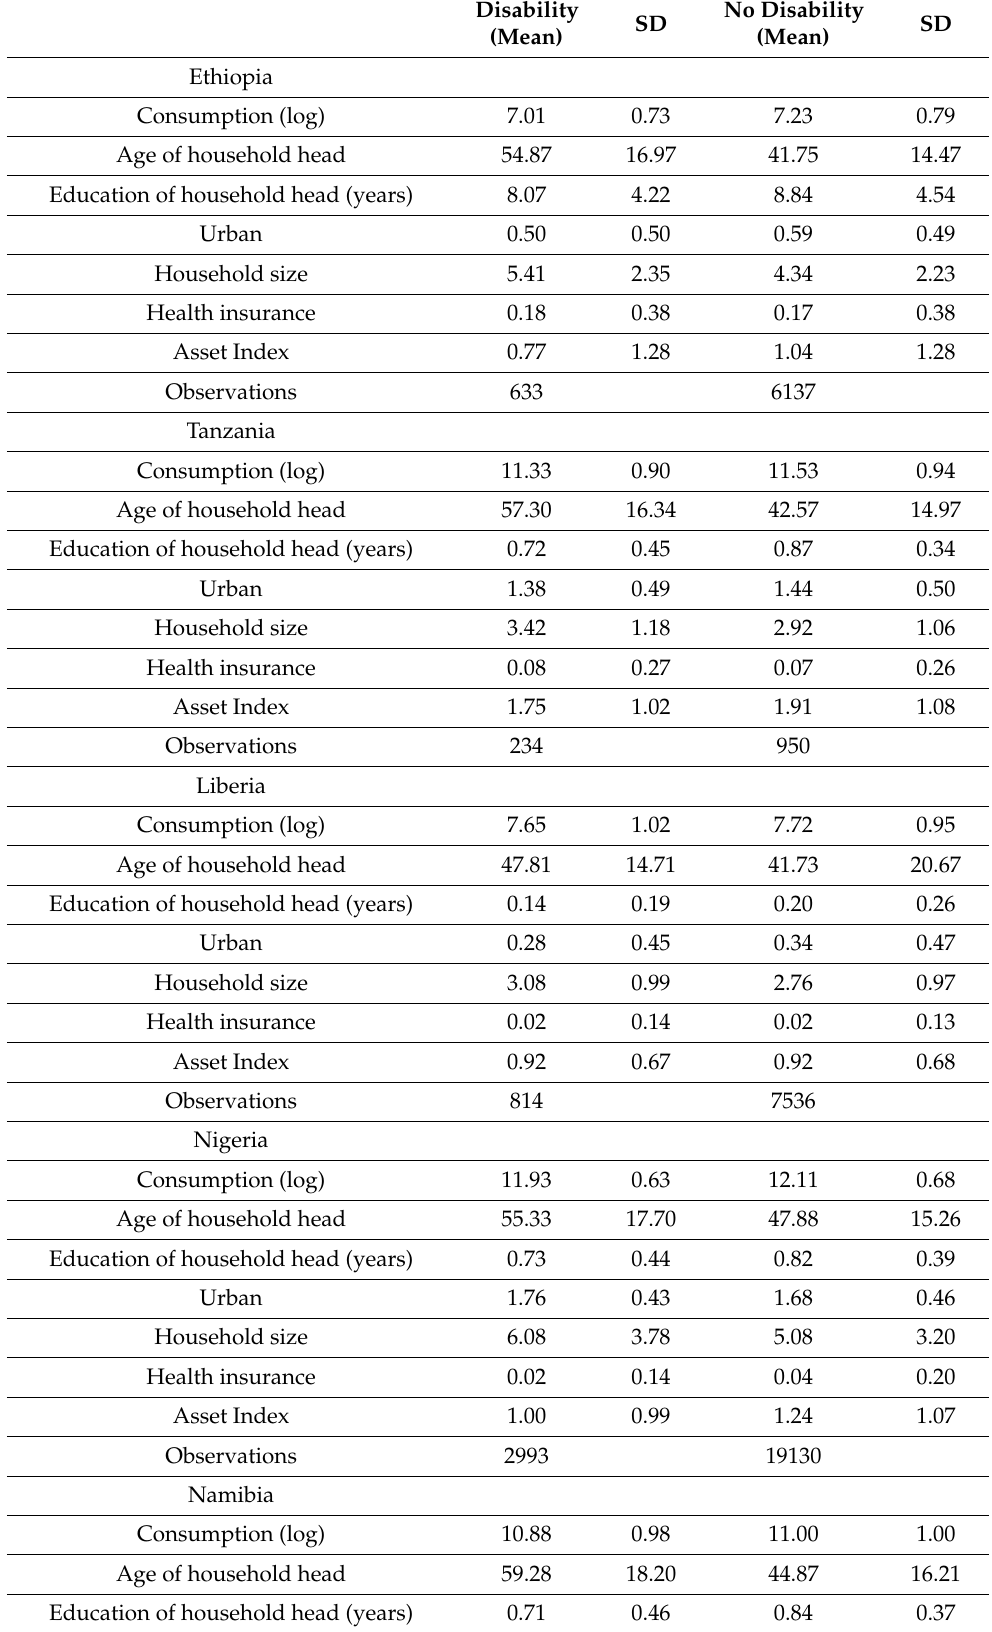
Table 1. Descriptive statistics by country and according to households with and without a person with a disability